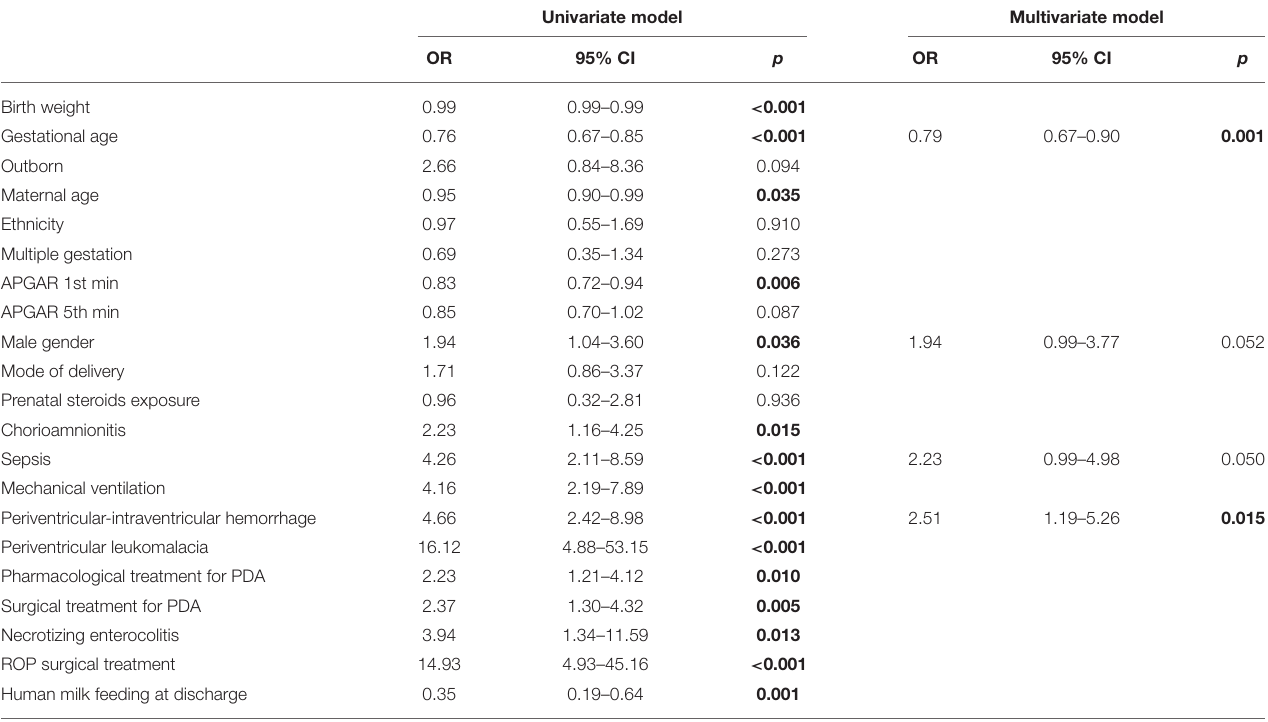
TABLE 4 | Association of perinatal data and severe functional disability at 24 month of corrected age.